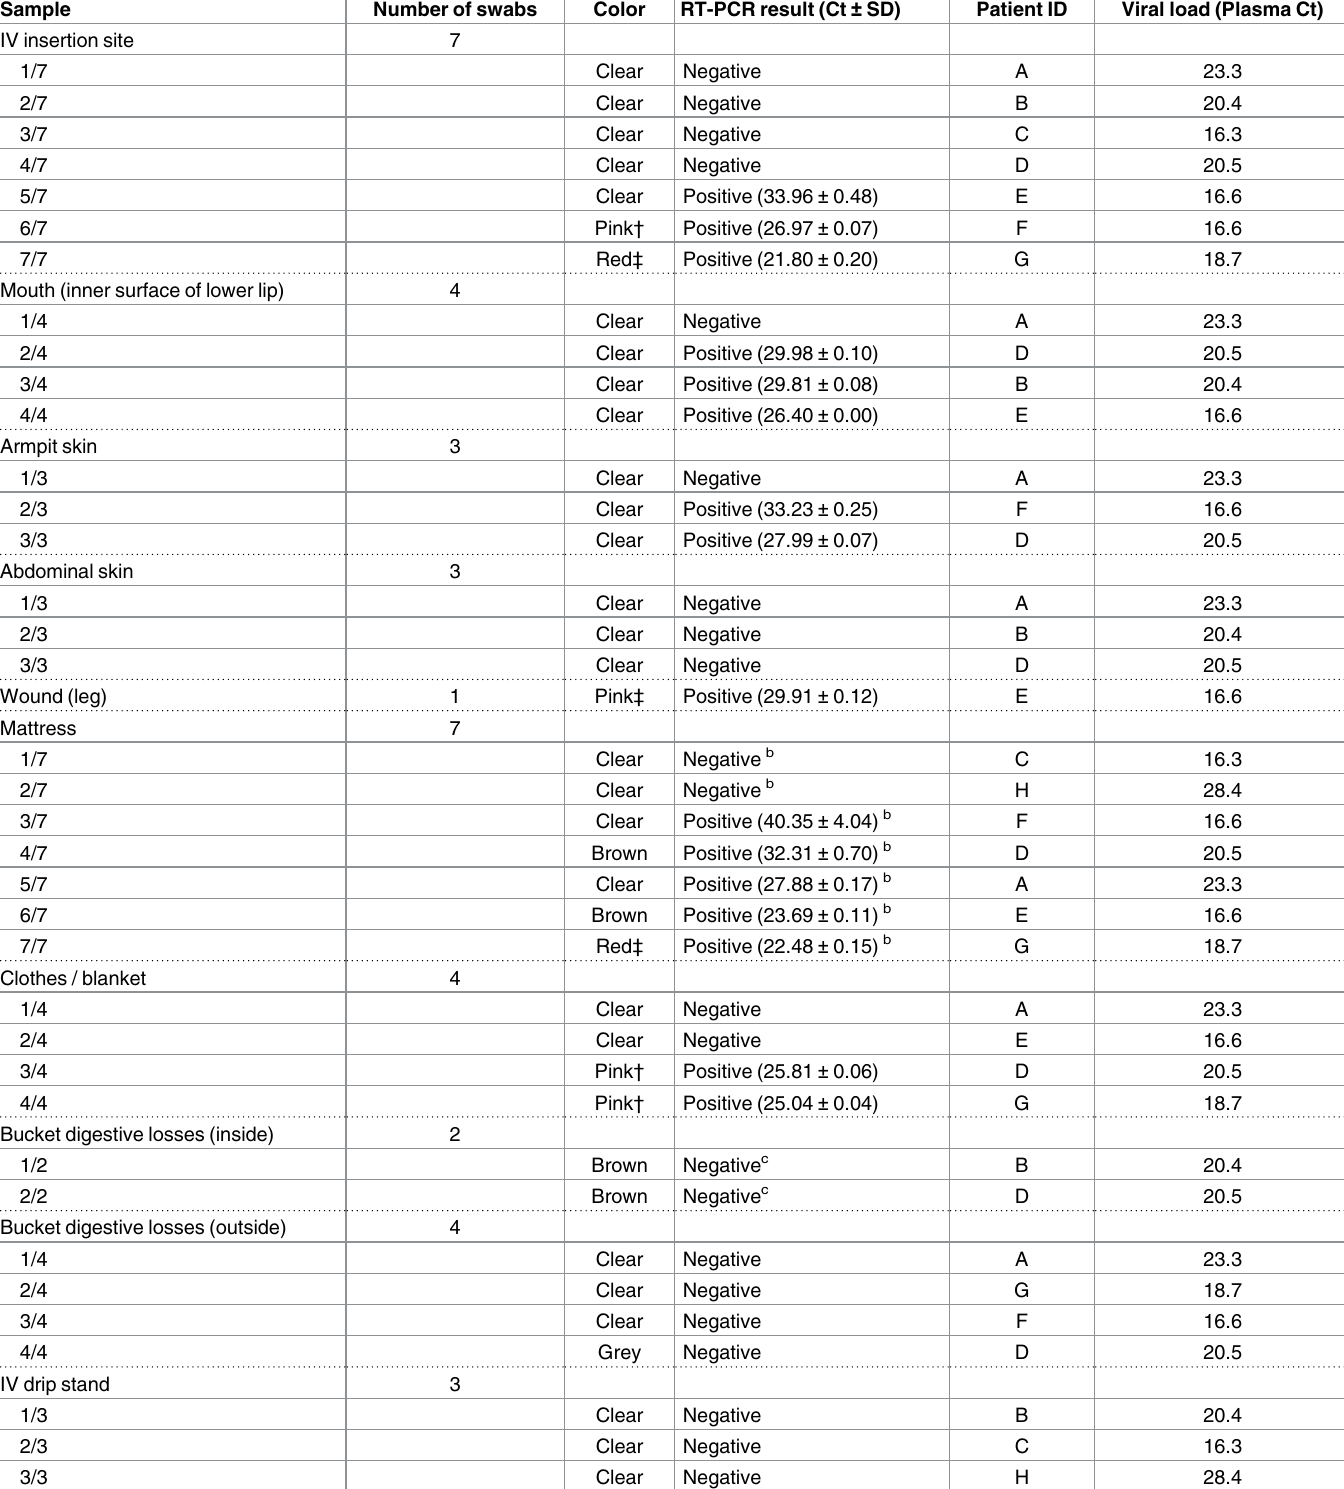
Table 1. Samples from the immediate vicinity of the